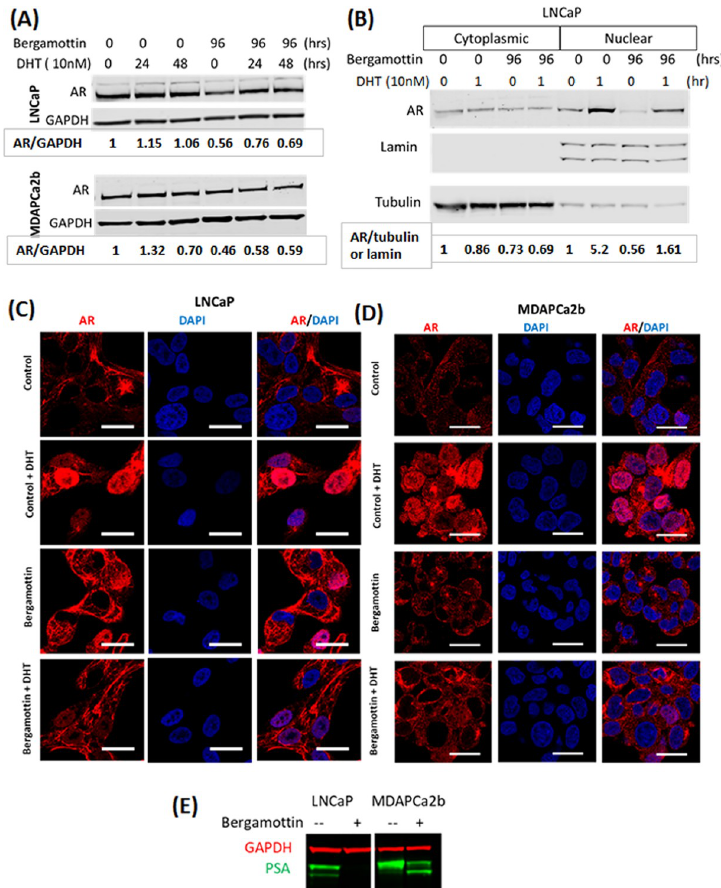
Fig 2. Bergamottin downregulated total AR expression, AR activation and downstream signaling: (A) Western blotting showed that bergamottin reduces total AR. GAPDH was used as an internal control for equal loading. Cells were plated in complete media, replaced with charcoal stripped serum and phenol red free media (CSSM) 24 hours after plating. Bergamottin (10 μ M) and vehicle control (DMSO) was added at the time of replacing with CSSM. DHT was added either 48 or 72 hours after replacing with CSSM depending on the treatment duration. (B) Analysis of AR nuclear localization shows that bergamottin reduces AR in nuclear fraction with or without DHT induction. Lamin and tubulin have been used as internal controls. The plating and bergamottin treatment time point was similar as (A) the DHT tretment was given 95 hours after replacement with CSSM. (C&D) Confocal microscopy showing effect of bergamottin on AR nuclear localization. Cell plating and treatment was similar to (B). Size bar 20 μ m. (E) Western blotting showing reduction in PSA production with bergamottin treatment (10 μ M, 96 hours). signaling. Bergamottin downregulated total AR levels in both LNCaP and MDAPCa2b cells by 50% (Fig 2A). DHT slightly increased the total AR expression in DMSO and bergamottin treated LNCaP and MDAPCa2b cells. Cell fractionation experiments with LNCaP cells showed that bergamottin inhibited nuclear translocation of AR consistent with CYP3A5 siRNA inhibi- tion reported earlier: nuclear AR with and without DHT induction was lower in the bergamot- tin treated cells compared to the control set (Fig 2B). The inhibition of nuclear translocation of AR was further confirmed in both the cell lines using confocal microscopy studies (Fig 2C and 2D). In bergamottin treated cells, active AR migration to the nucleus with DHT induction was significantly reduced versus the control (DMSO) treated cells. Interstingly, we observed this pattern of increased cytoplasmic AR in our confocal images with bergamottin similar to other inhibitor treatments (e.g. ritonavir, [21]) observed earlier. Bergamottin also significantly